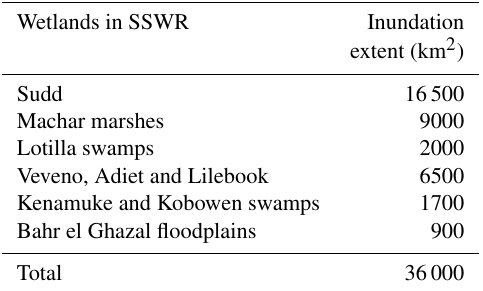
Table A1. The total of permanent SSWR inundation extent from Huges and Huges